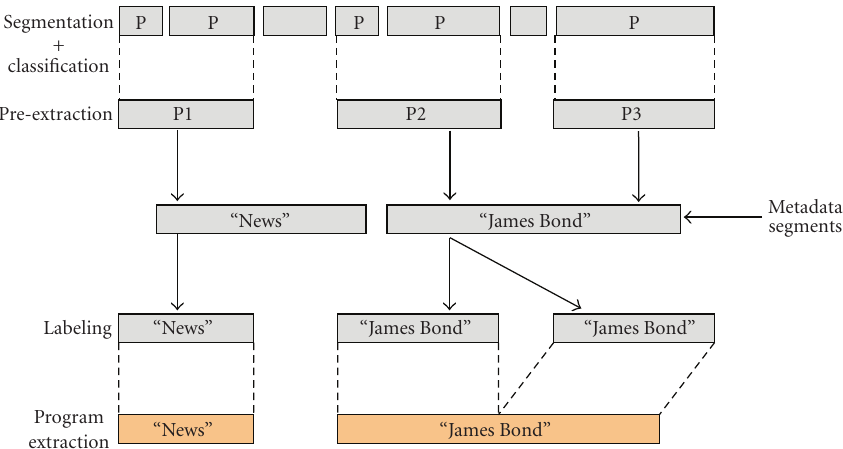
Figure 9: Program extraction and labeling.